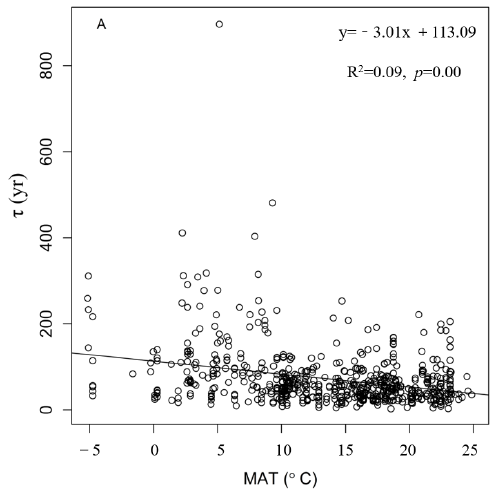
Figure A14. Sensitivity of subsoil organic C turnover time (τ, year) to changes in MAT (°C) without the values obtained from the turning from linear regression.